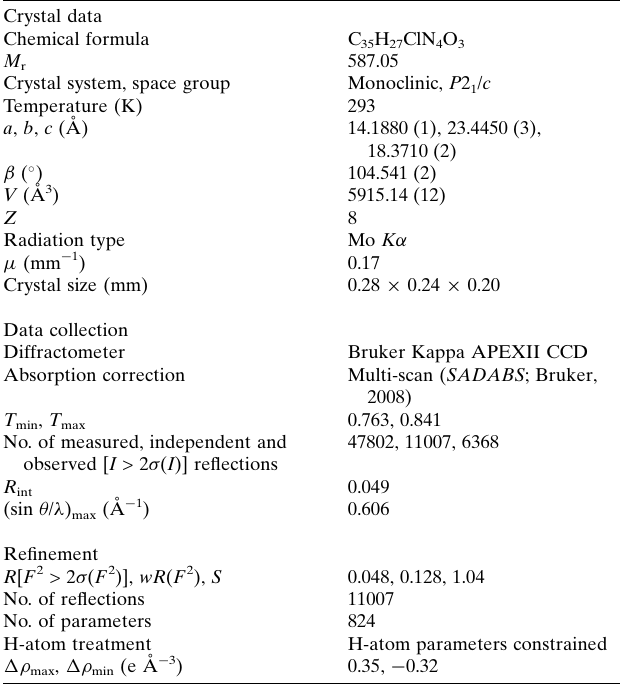
Table 1 Hydrogen-bond geometry (A˚ , (cid:4) ). Cg 1, Cg 2 and Cg 3 are the centroids of rings C14 B –C19 B , C3 B –C5 B /C33 B – C35 B and C3 A –C5 A /C33 A –C35 A ,